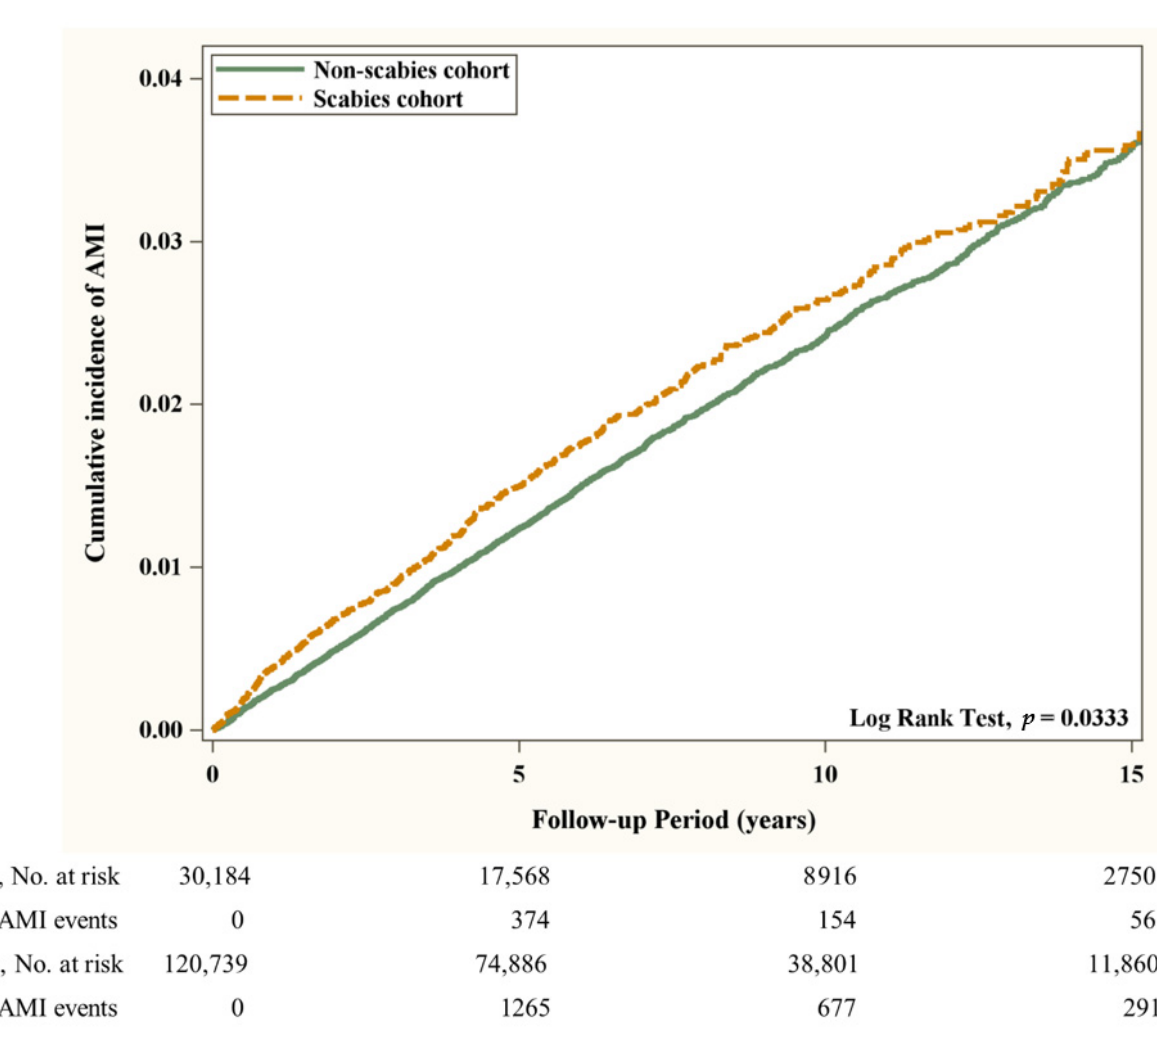
Figure 2. Cumulative incidence of AMI in patients with and without scabies. Abbreviation: (AMI), Acute Myocardial Infarction.